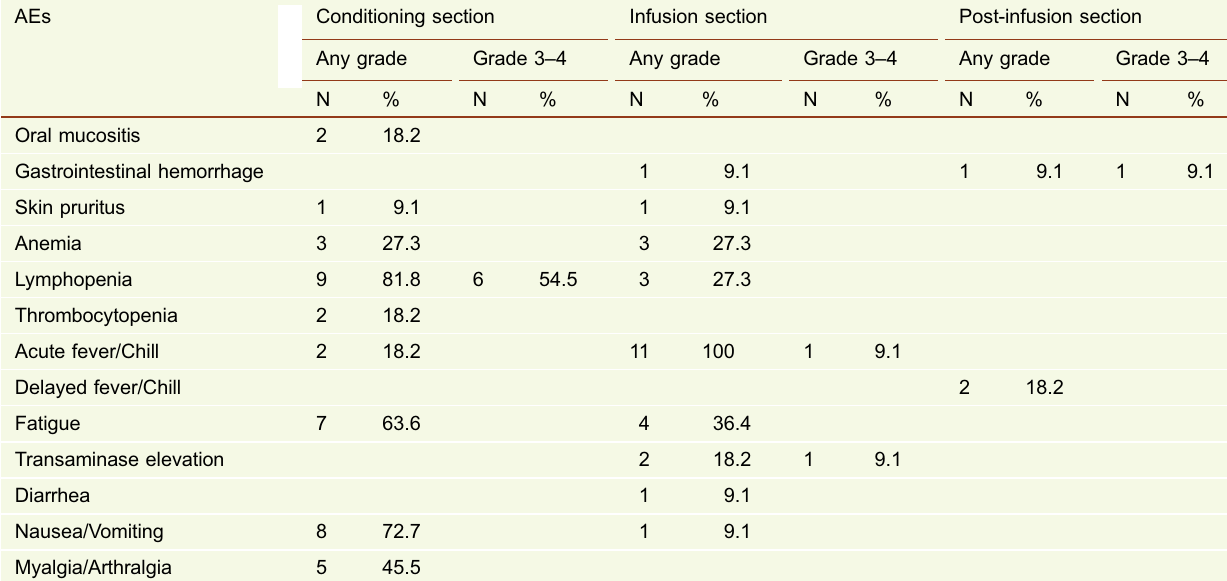
Table 2. Adverse events related to CART-HER2 therapy